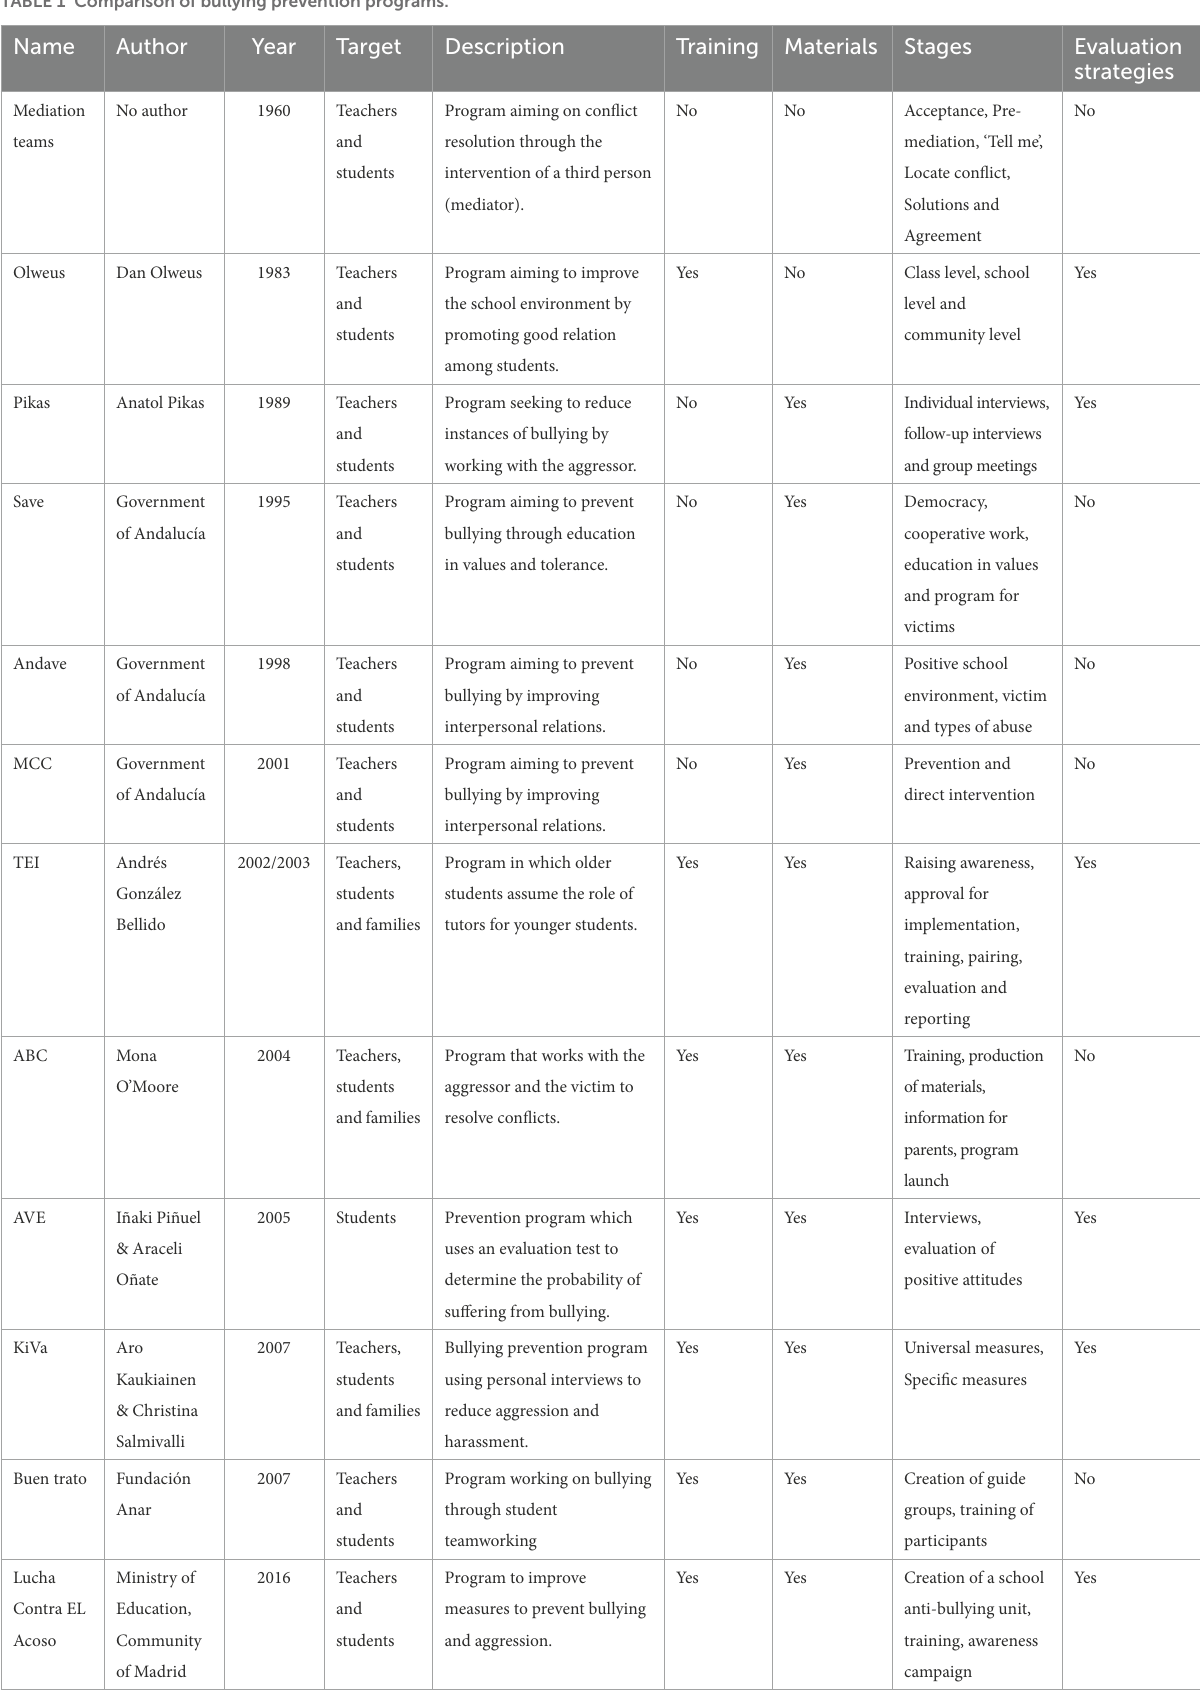
TABLE 1 Comparison of bullying prevention